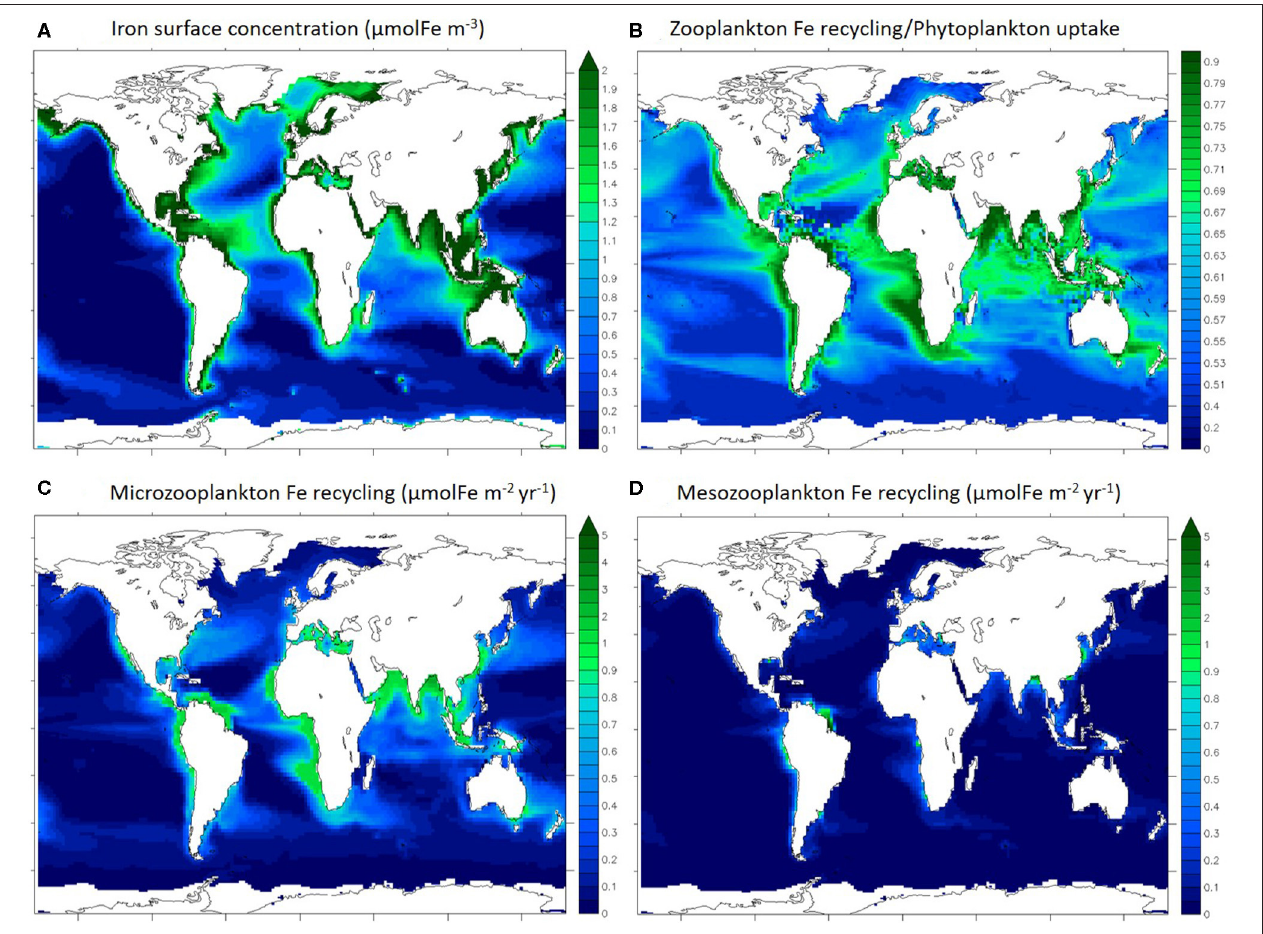
FIGURE 2 | Maps of annually averaged iron concentration in the first 100 m (A) , iron recycling/uptake ratio (B) , annually averaged microzooplankton (C) , and mesozooplankton (D) iron recycling integrated for the first 100 m. Ice covered regions (defined as grid points with an annually averaged ice cover > 50%) are masked